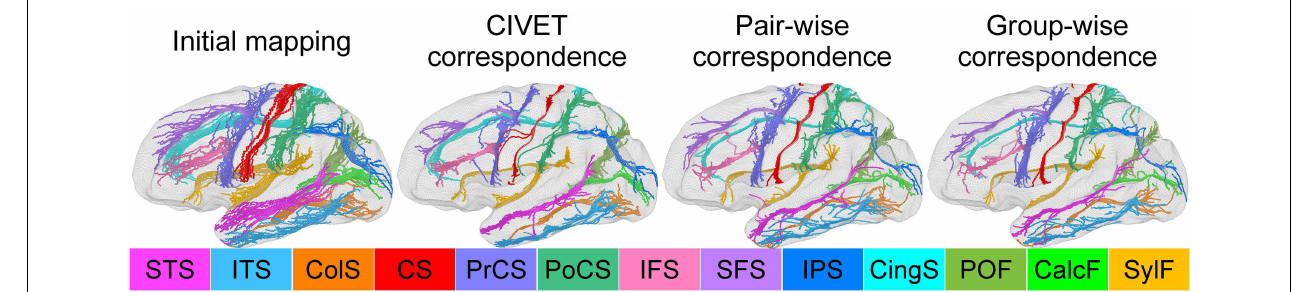
FIGURE 7 | Sulcal curve alignment by initial spherical mapping (1st column), CIVET correspondence (2nd), pair-wise correspondence (3rd), and group-wise correspondence (4th). The arrows indicate improved agreement in the group-wise as compared to the pair-wise correspondence.